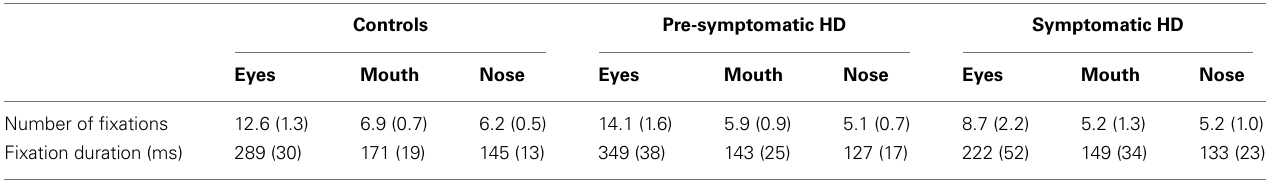
Table 2 | Mean fixation duration and number of fixations for the pre-symptomatic and symptomatic HD group and control group separately as a function of